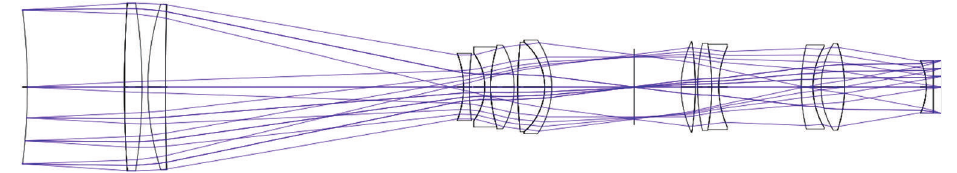
Figure 9: The basic optical scheme for the VIS